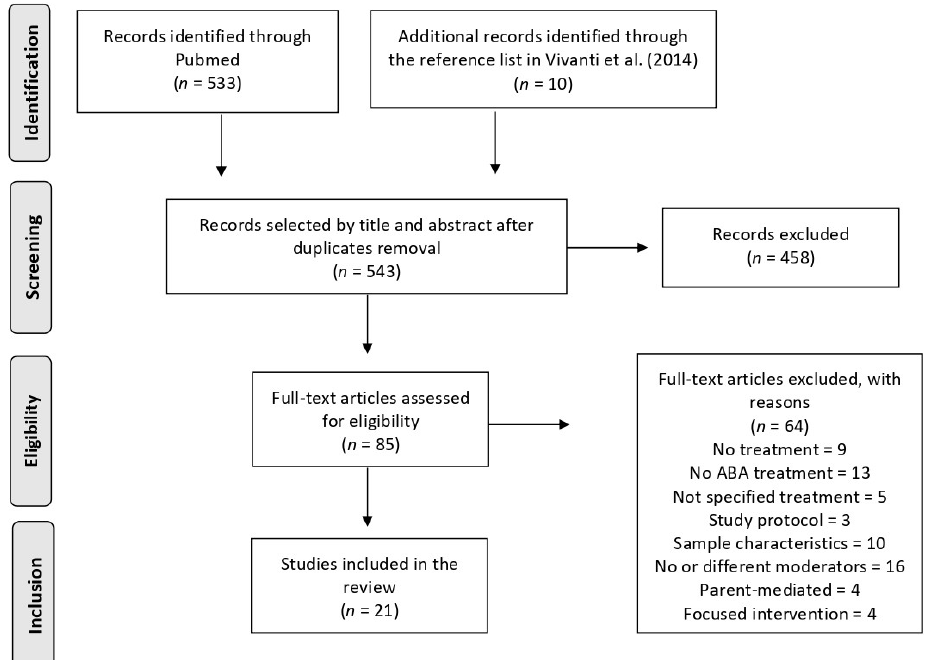
Figure 1. Adapted from the PRISMA flow diagram [24], showing the steps of the selection process undergone by the studies in this review.